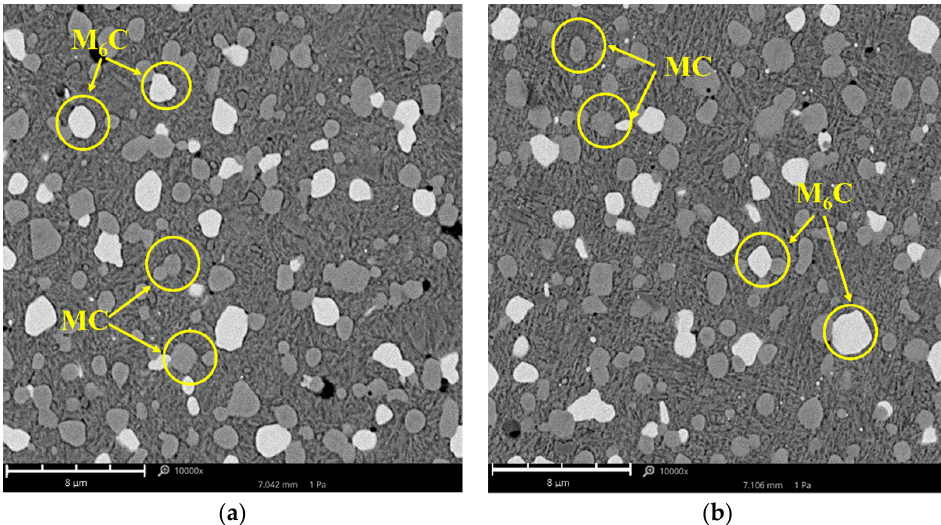
Figure 3. The microstructure of Vanadis 60 SuperClean steel hardened in oil ( a ) and in water ( b ). It was etched with Nital 5%. Scanning electron microscopy.